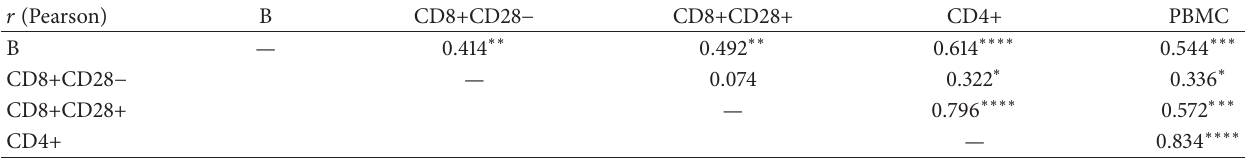
Table 2: Correlation of telomere length among different cell types at the base visit ( 𝑁 = 39 ).